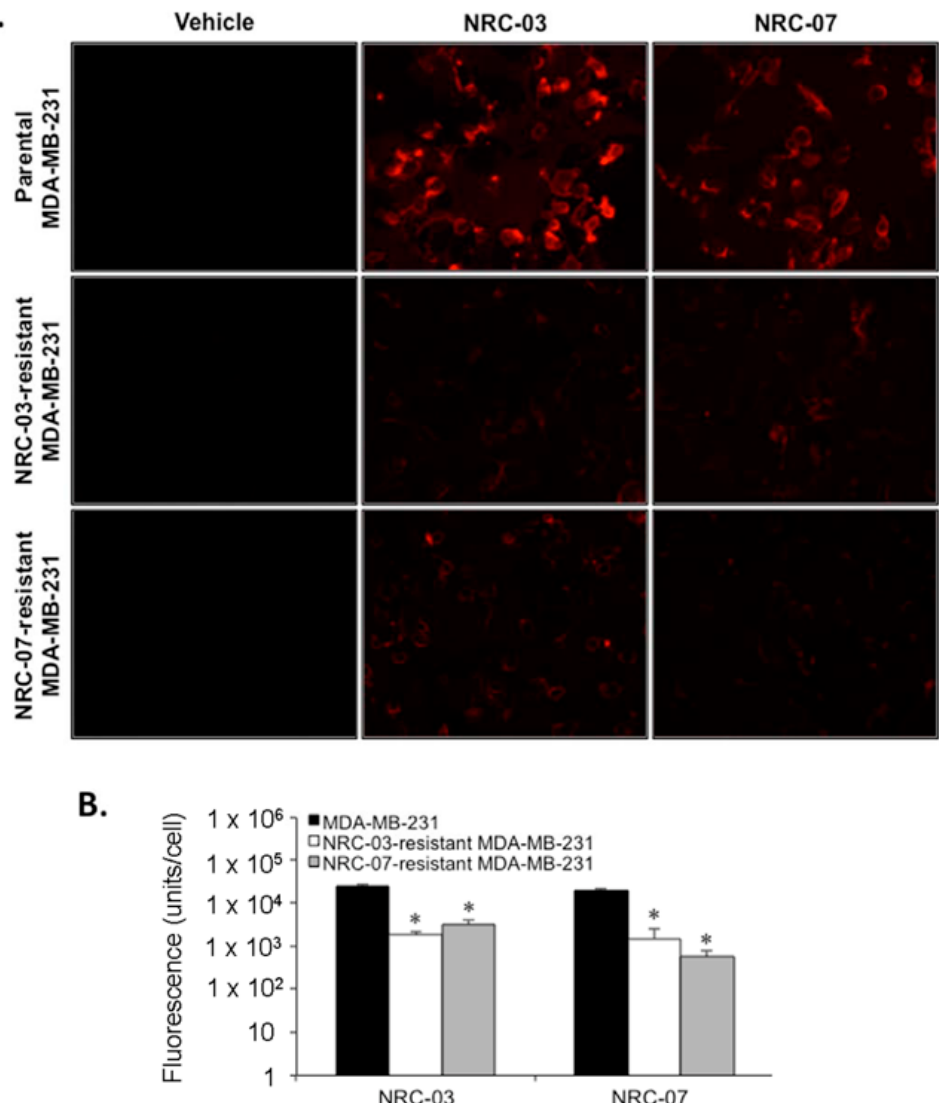
Figure 3. NRC-03 and NRC-07 bind poorly to NRC-03-resistant and NRC-07-resistant breast cancer cells. ( A ) Parental MDA-MB-231 cells, NRC-03-resistant MDA-MB-231 cells, and NRC-07-resistant